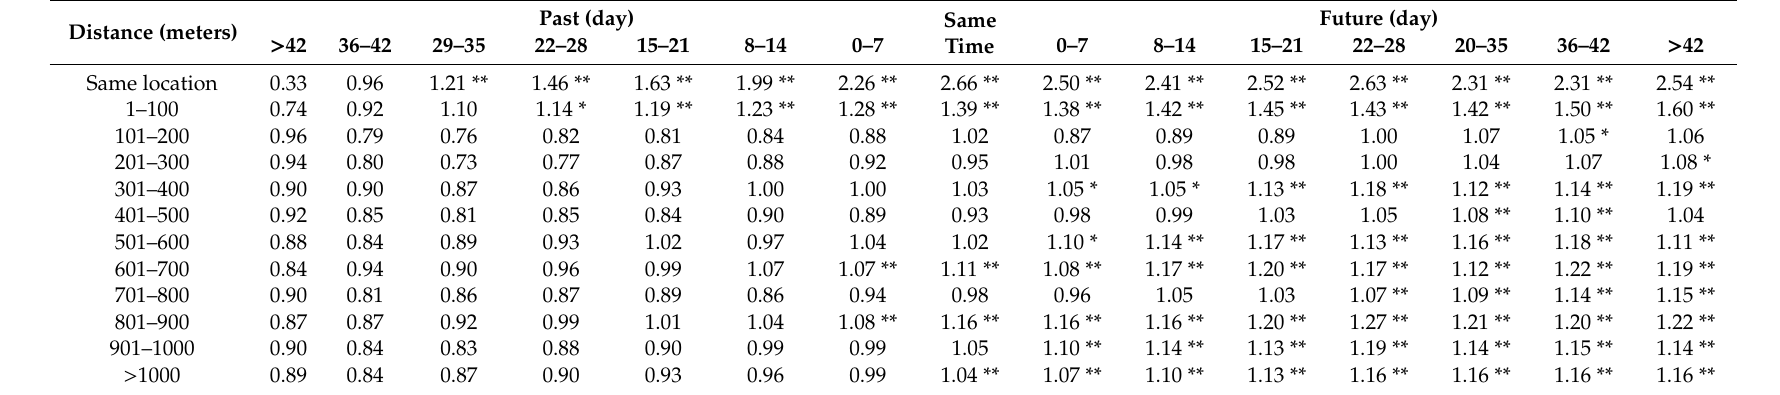
Table 5. Risk of PP after VMVT hotspot.